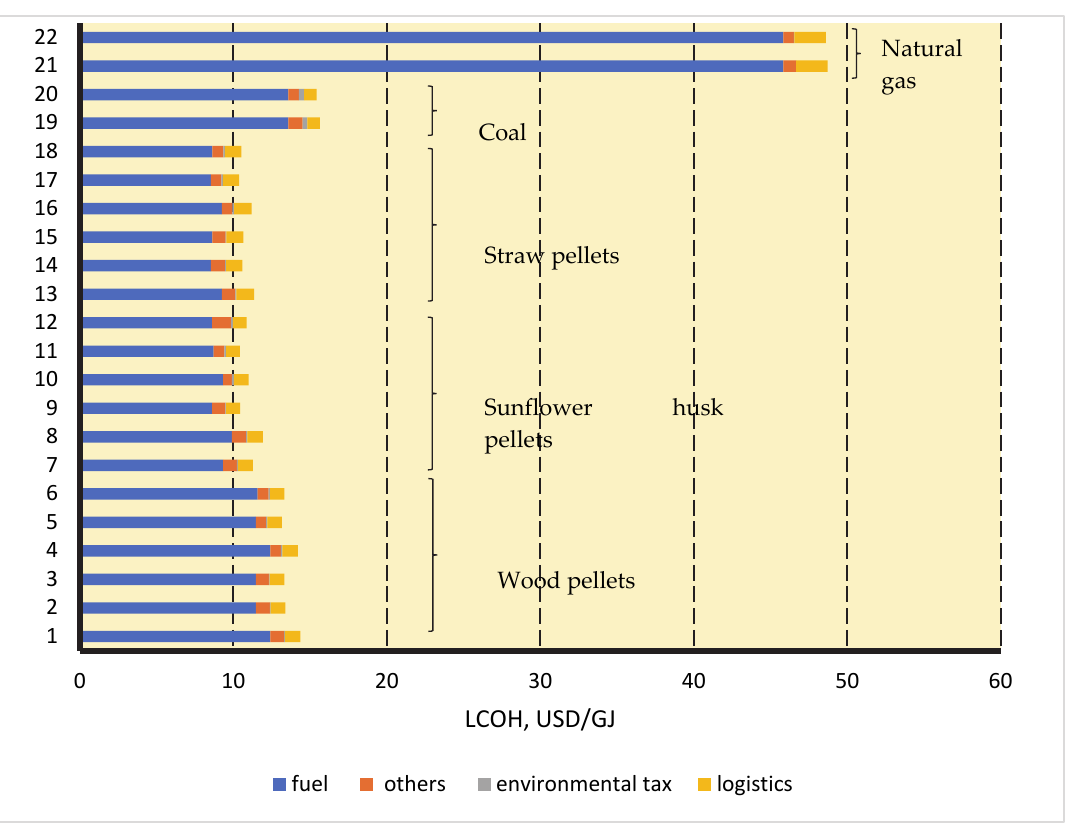
Figure 2. LCOH structure in January 2022 (the number on the x -axis corresponds to the first column in Table 4).